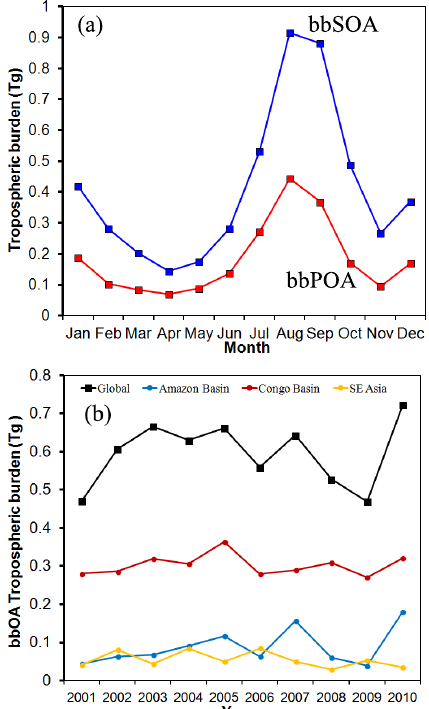
Figure 9. (a) Monthly averaged predicted tropospheric burden (Tg) of bbSOA (in blue) and bbPOA (in red) and (b) annual aver- age tropospheric burden of total biomass burning OA (bbOA) dur- ing